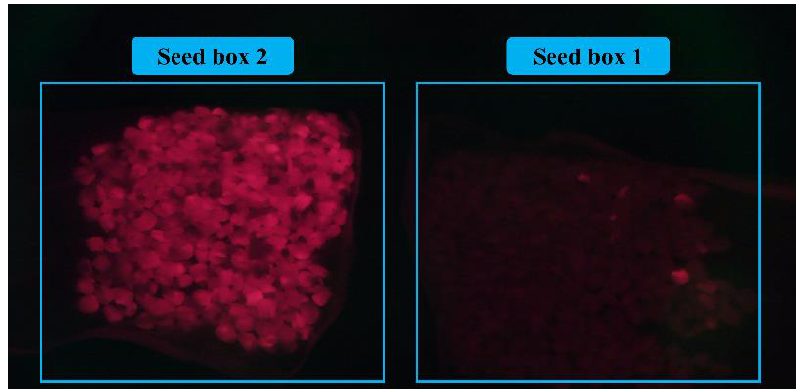
Figure 15. Sorting results of sorting system at kernel intervals of 0.5 s.